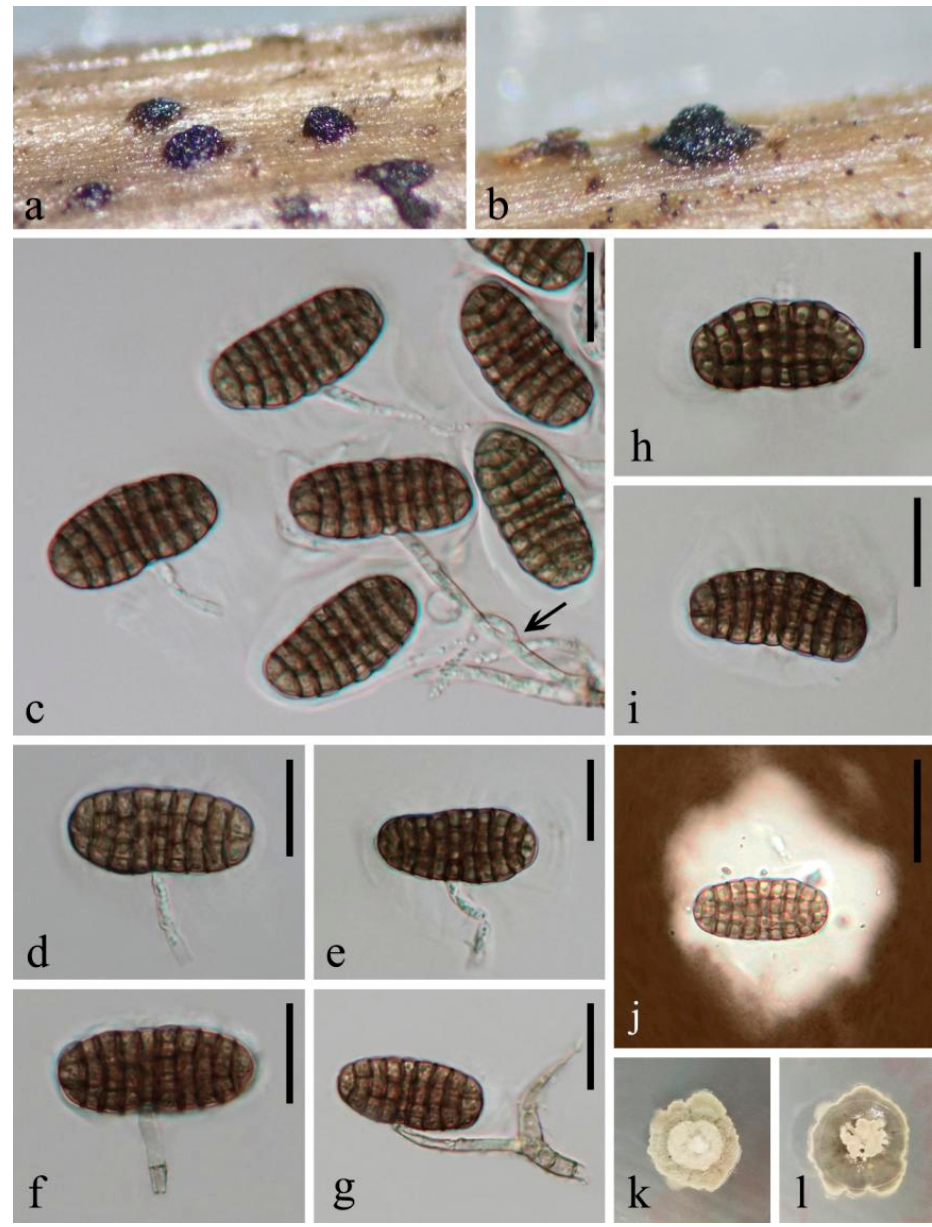
Figure 3. Coleodictyospora muriformis (MFLU 18-1544, holotype). ( a , b ) sporodochia with a mass of conidia on natural substrate; ( c ) conidia, conidiogenous cells and conidiophores (arrow shows branched conidiophore); ( d , e ) conidia with conidiogenous cells; ( f , g ) conidiophore bearing conidia; ( h , i ) reniform conidia with semi-gelatinous sheaths (h clearly shows the dark brown bands at the conidial transverse septa); ( j ) conidium in Indian Ink showing an irregular sheath; ( k , l ) colony on PDA (left-front, right-reverse). Scale bars, ( c – i ) 20 μ m; ( j ) 30 μ m.